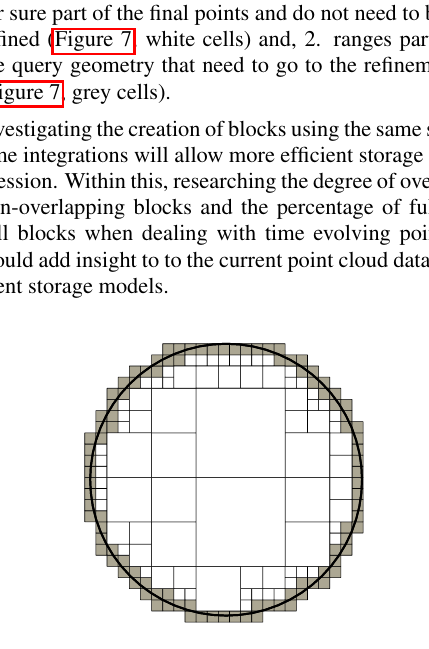
Figure 7: Separating internal ranges and ranges on boundary. White cells are inside the query region. Grey cells are partially inside the query